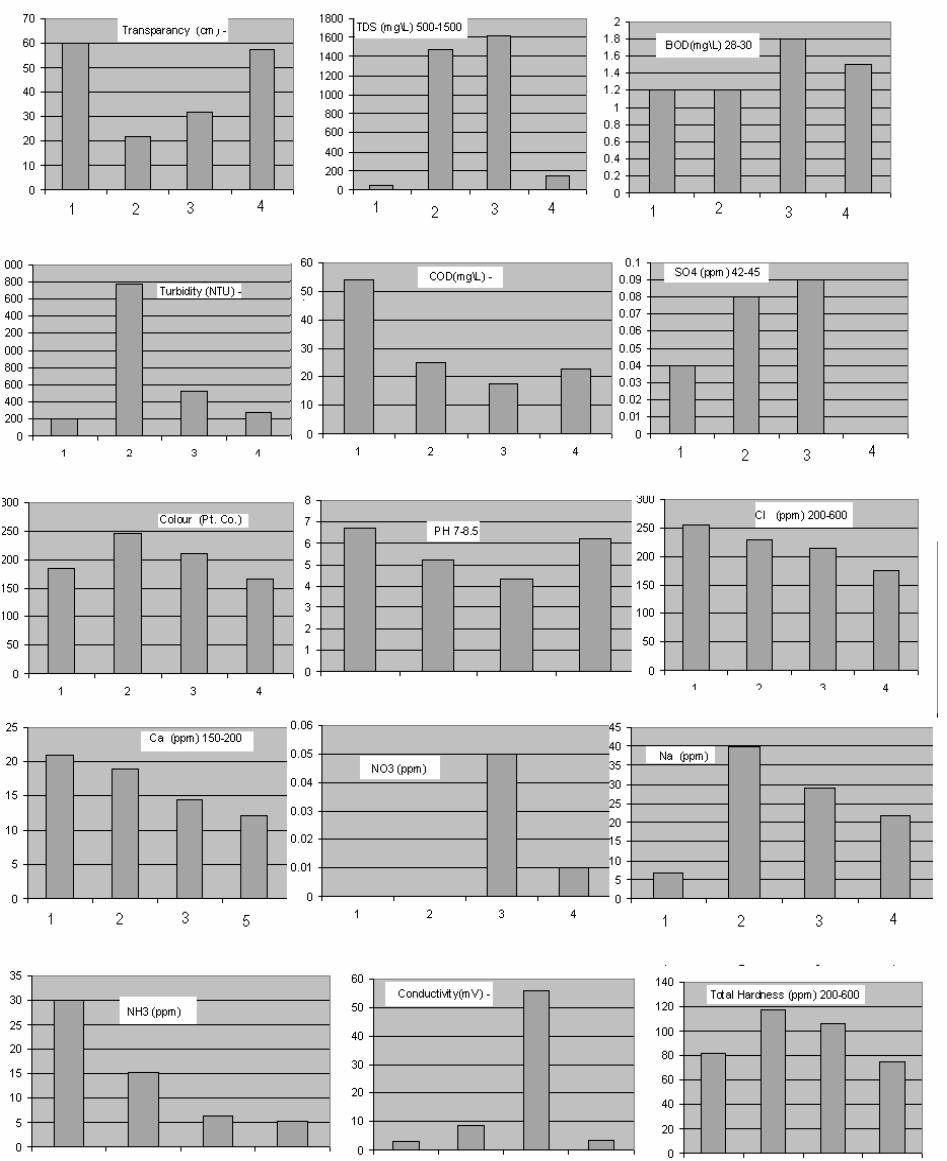
Figure 1 . Showing select physico-chemical parameters of various samples of water in 4